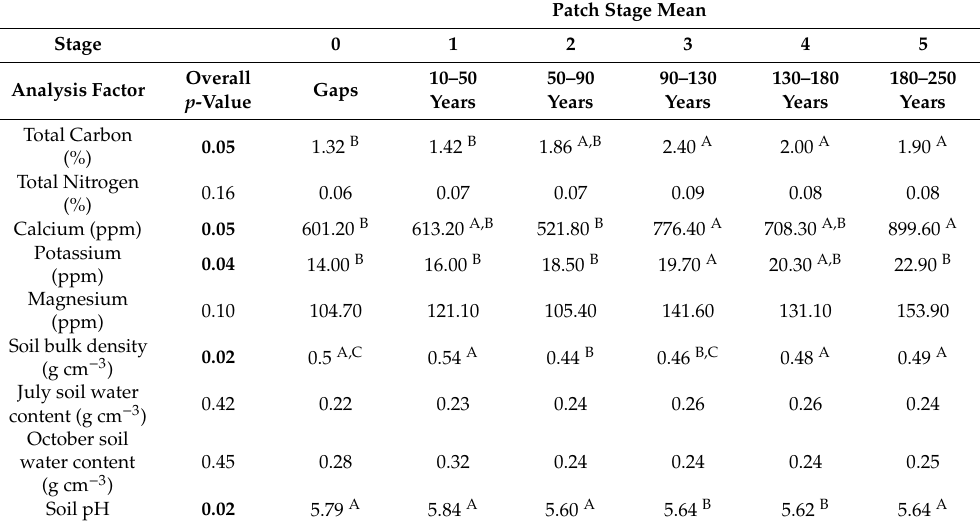
Table A2. Mean values of di ff erent soil attributes in each of the six patch stages and overall stage e ff ect p -value from PerMANOVA analyses. Bold p -values indicate significant results ( p < 0.05) and shared letter subscripts denote non-significant di ff erences indicated by PerMANOVA pairwise comparisons.